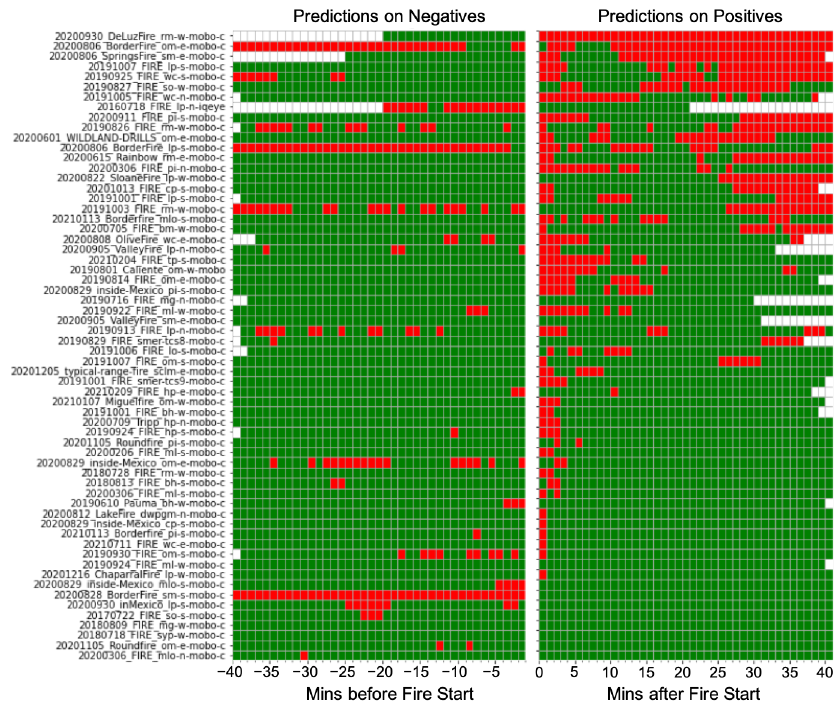
Figure 3. SmokeyNet’s performance per fire on both negative and positive images. Green denotes a correct prediction; red denotes an incorrect prediction; white denotes images missing from the sequence. Hence, red on the left are false positives, red on the right are misses. Common misses include faint smoke occurring at the start of the fire or dissipating smoke at the end of the fire sequence. Common false positives include low-altitude clouds and